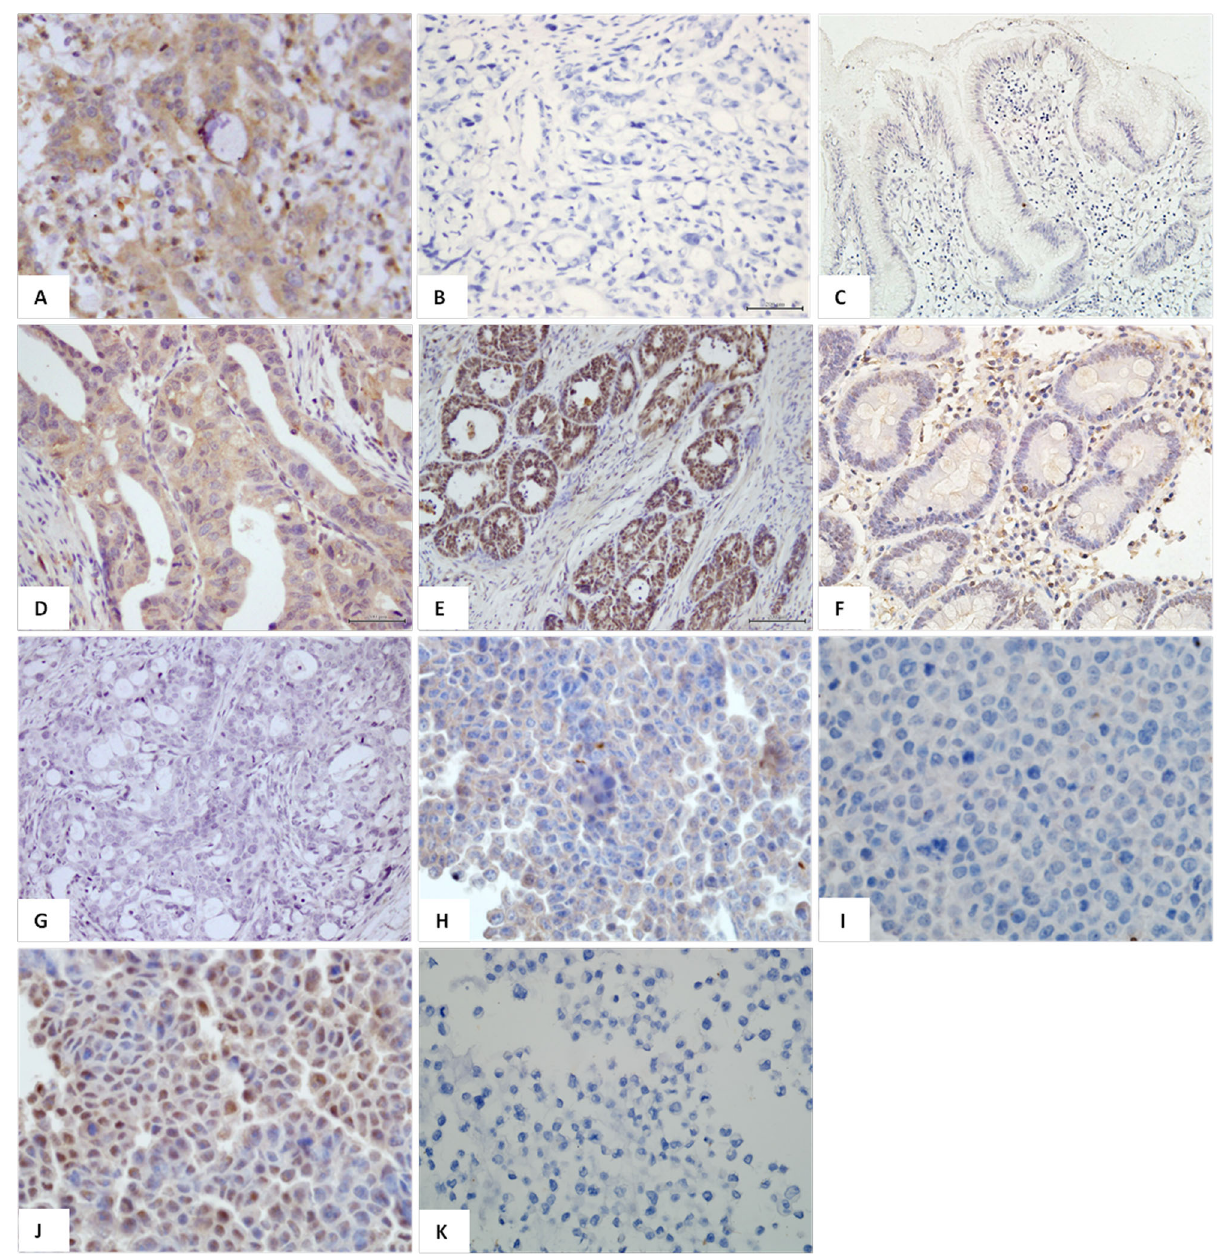
Figure 1. Immunohistochemical analysis indicated that most of the cancer cells showed cytoplasmic Gal-9 immunostaining(A), but a small number of gastric cancer cells(B) and gastric normal mucusa showed negative immunostaining for Gal-9 (C). Gastric tumor cells showed a clear cytoplasmic(D),nuclear positivity (E), or negative for Tim-3 immunostaining (G). (F) showed a weak Tim-3 positive staining in gastric normal mucusa. Cell lines SGC-7901, BGC-823 and MGC-803 and GES-1 showed weak cytoplasmic Gal-9 immunostaining (H, BCG-823), but MKN45 showed negative immunostaining for Gal-9(I). Four gastric cancer cell lines also showed strong cytoplasmic and nuclear positivity for Tim-3 staining (J, BCG-823 cell line). However, GES-1 cells showed negative staining for Tim-3(K). Original magnifications, x200 and